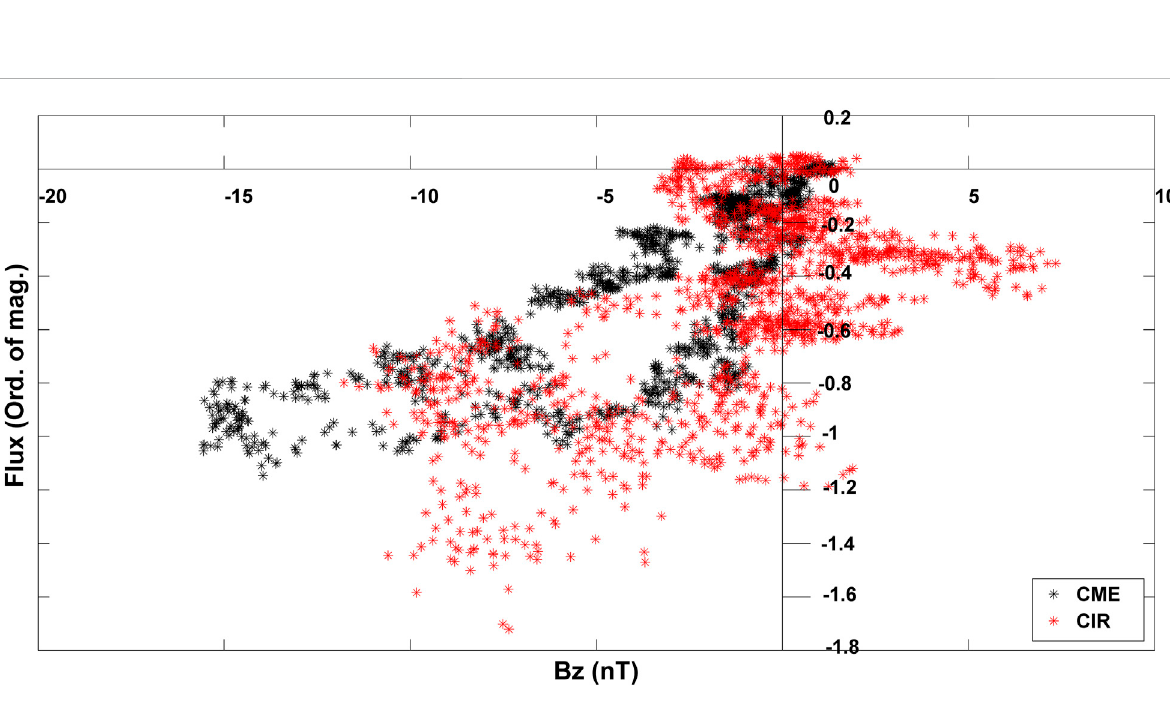
Frontiers in Astronomy and Space